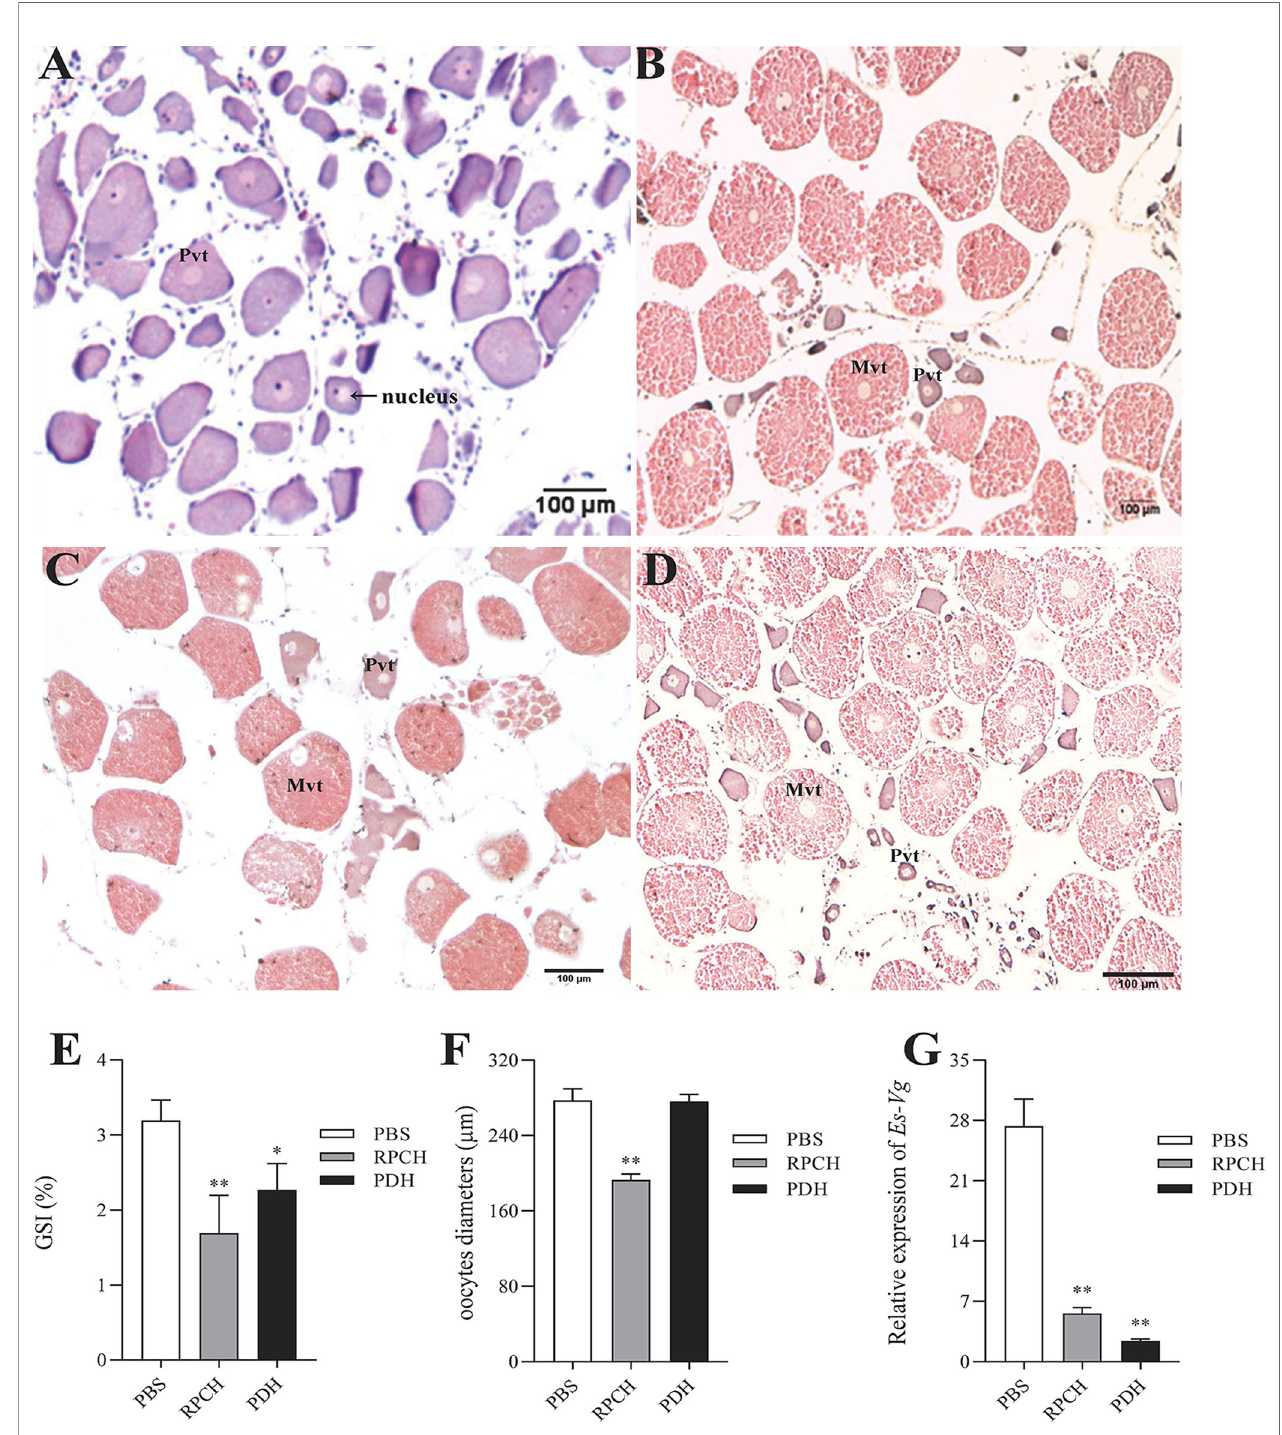
FIGURE 5 | Effects of in vivo injection of Es-RPCH and Es- b - PDH peptides on the ovarian development in E. sinensis . Histological observation: Ovarian tissue sections at the fi rst day (A) and the 30 st day (B) post injection of PBS; ovarian tissue sections at the 30 st day post injection of the Es-RPCH peptides (C) and Es- b - PDH peptides (D) . Inhibitory effects on the gonadosomatic index (E) , mean oocytes diameters (F) , and relative expression level of Es-Vg mRNA as revealed by qPCR (G) . Pvt, previtellogenesis. Mvt, middle vitellogenesis. The data are presented as means + SD ( n = 5 ). Asterisks (*) and double asterisks (**) represent statistically signi fi cant difference as compared with PBS control ( P < 0.05 and P < 0.01). Scale bar = 100 m